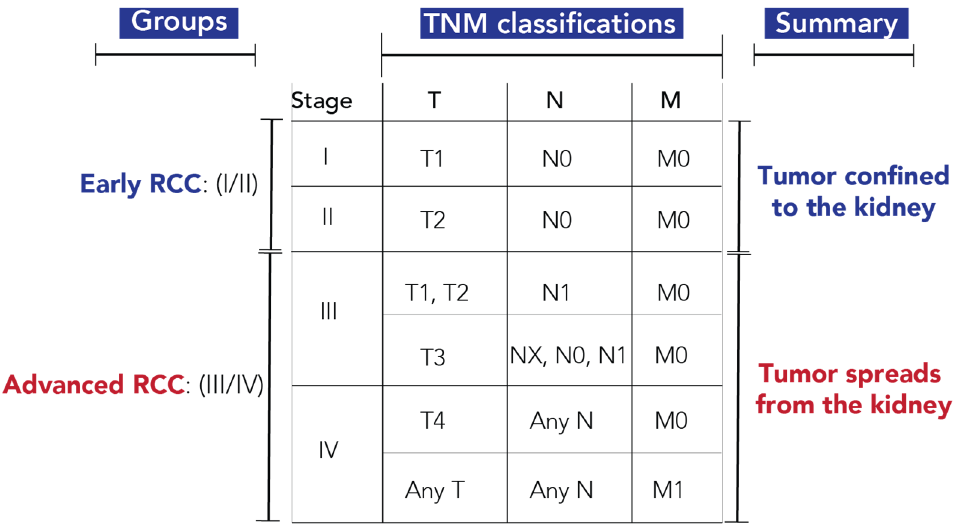
Figure 1. Staging protocol for classification of early- and advanced-stage RCC. Abbreviations: T, primary tumor; T1, the tumor is 7 cm or less in its greatest dimension and limited to the kidney; T2, the tumor is greater than 7 cm in its greatest dimension but limited to the kidney; T3, the tumor extends into major veins or perinephric tissues but not into the ipsilateral adrenal gland and not beyond Gerota fascia; T4, tumor invades beyond Gerota fascia (including contiguous extension into the ipsilateral adrenal gland); N, regional lymph nodes; NX, regional lymph nodes cannot be assessed; N0, no spread to regional lymph nodes; N1, spread to regional lymph node(s); M, distant metastasis; M0, no distant metastasis; M1, distant metastasis [3] .